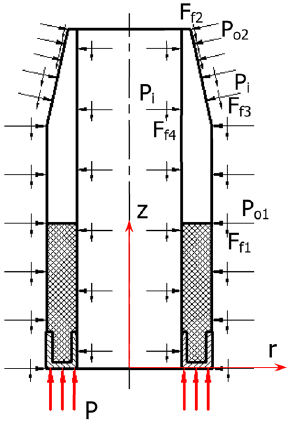
Fig. 9 Force diagram of rubber sleeve during